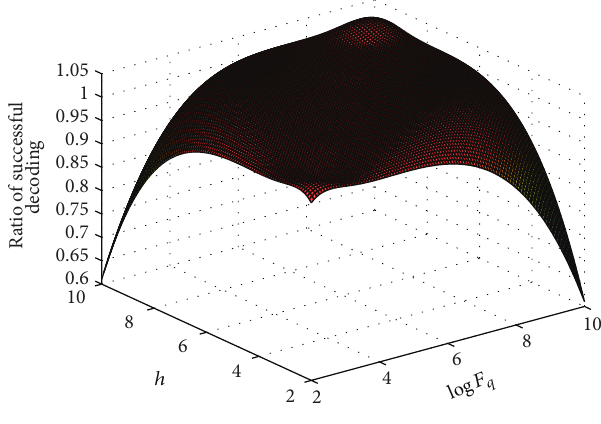
Figure 2: Rate of successful decoding versus 𝐹 𝑞 and the maximum multicast capacity.